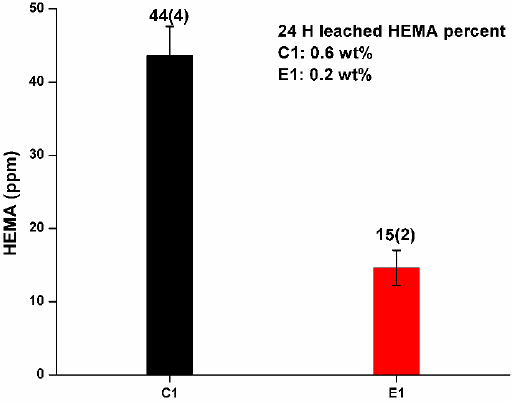
Figure 4. Cumulative HEMA release from the C1 and E1 polymers in water at 37 ◦ C for 24 h. Figure 4 . Cumulative HEMA release from the C1 and E1 polymers in water at 37 °C for 24 h.